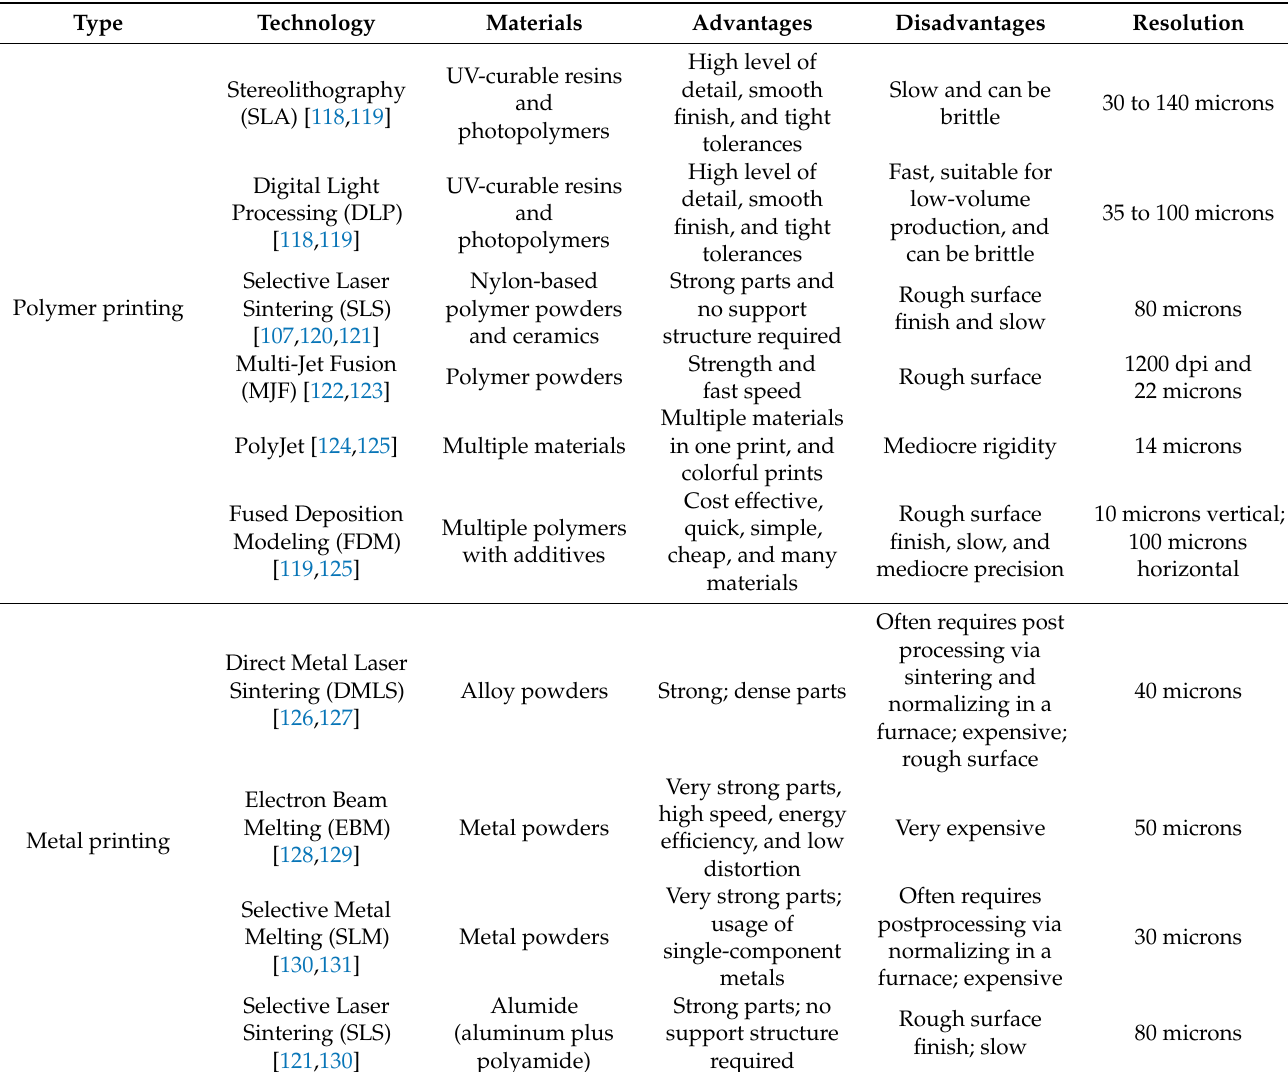
Table 1. Advantages and disadvantages of various 3D printing